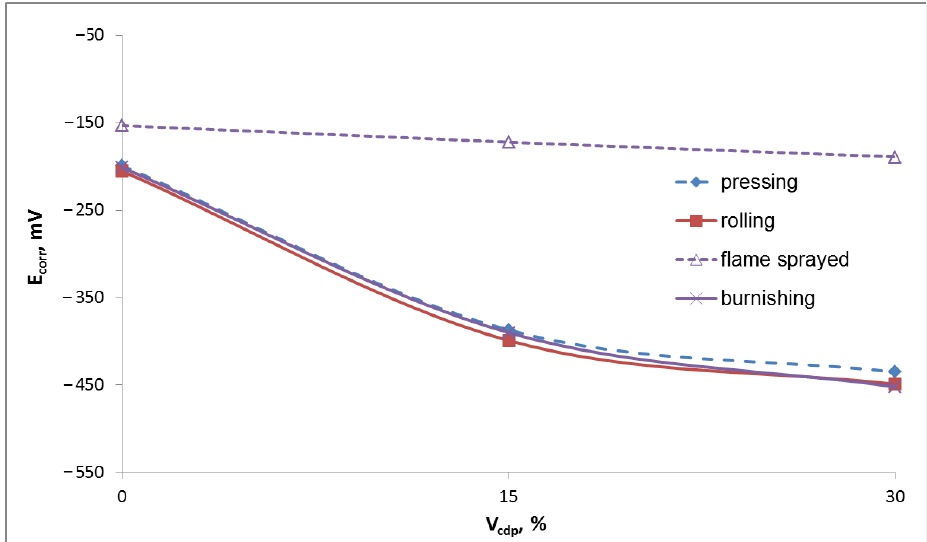
Figure 5. The influence of the volume fraction ceramic dispersed phase in the composite coatings on corrosion potential after pressing, rolling, burnishing and flame spraying.